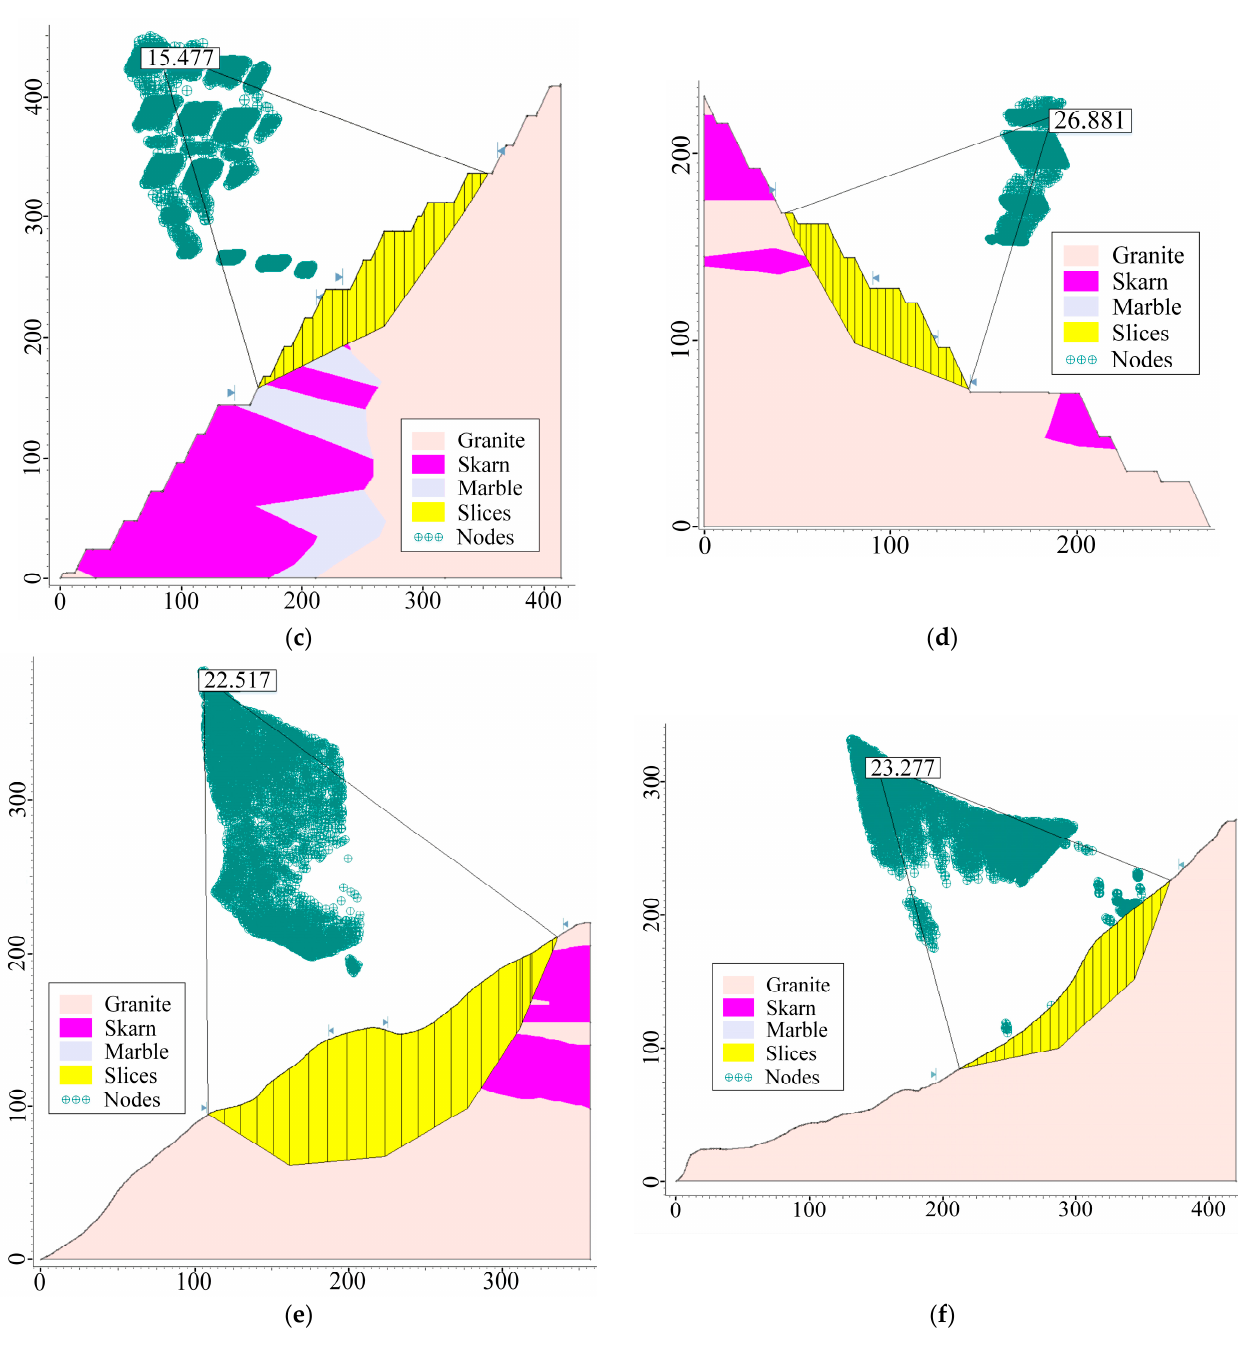
Figure 7. Calculation results of the limit equilibrium method (self ‐ weight): ( a ) R1; ( b ) R3; ( c ) R4; ( d ) R8; ( e ) Z1; ( f ) Z4.